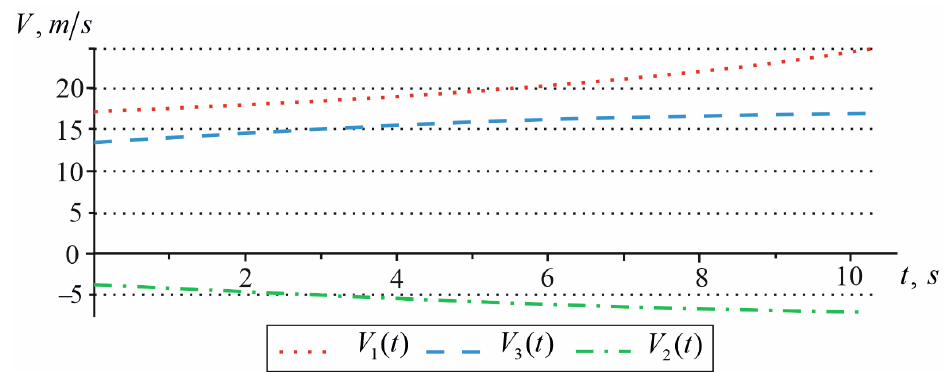
Figure 8. Measured change in current distances along each of the beams (second simulation).